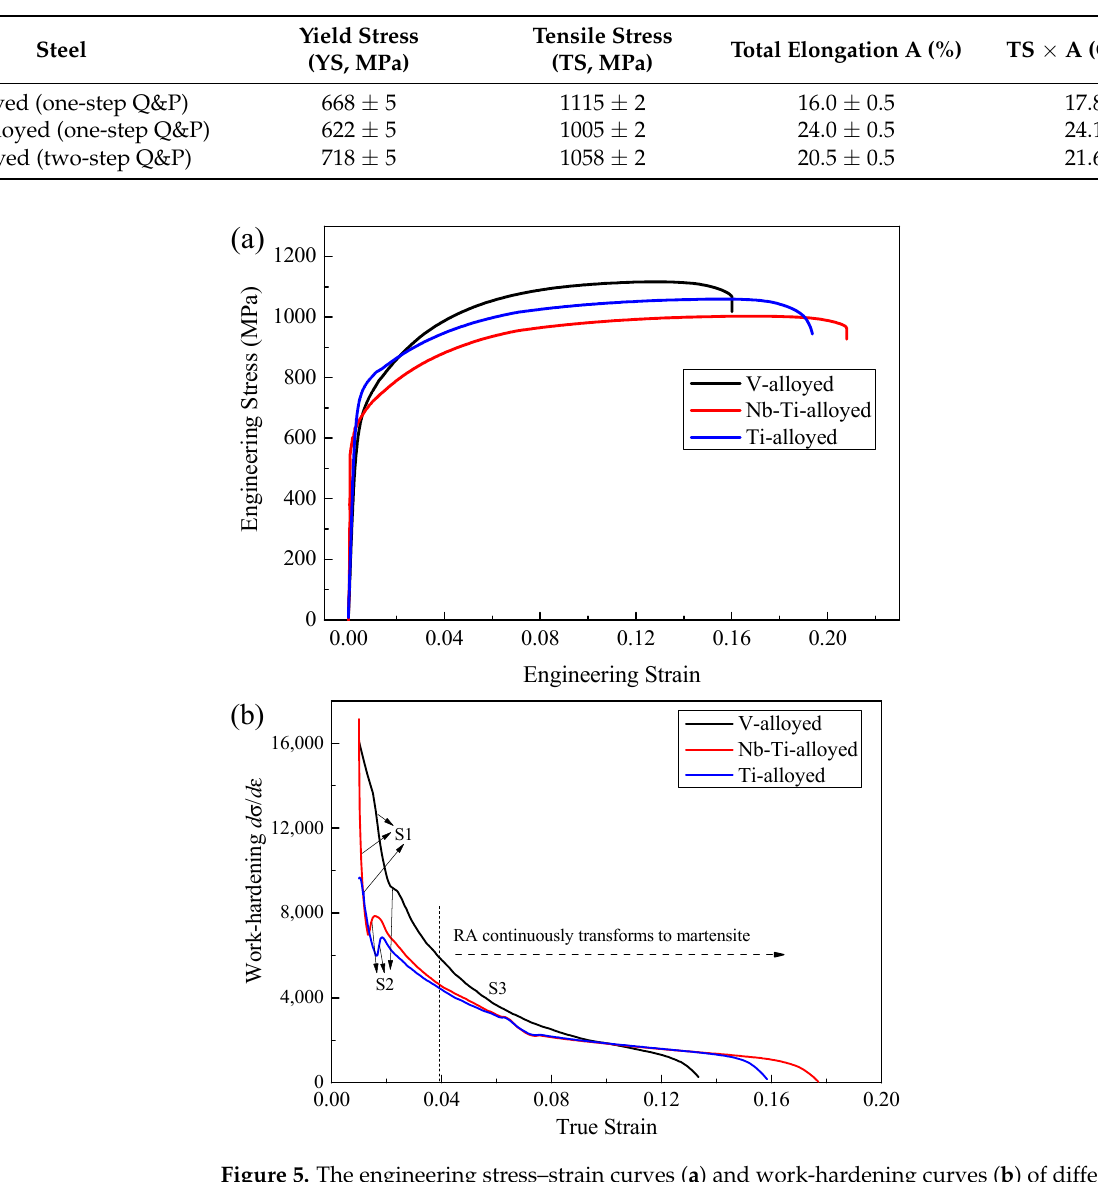
Figure 5. The engineering stress–strain curves ( a ) and work-hardening curves ( b ) of different micro- alloyed Q&P steels.